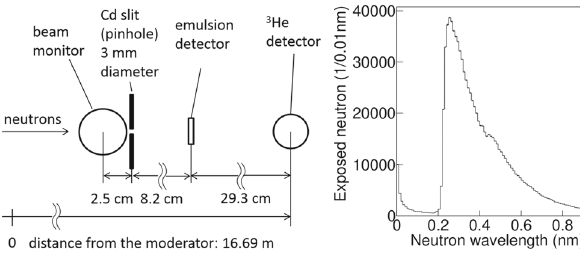
Fig. 2 Left: a schematic view of the experimental setup. Right: the wavelength distribution taken by the 3 He detector